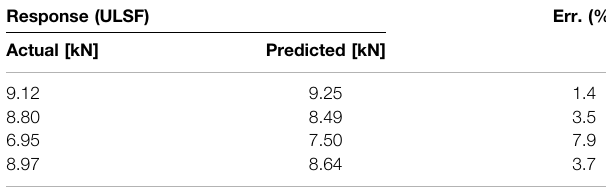
TABLE 4 | Actual vs. Predicted ULSF on the test